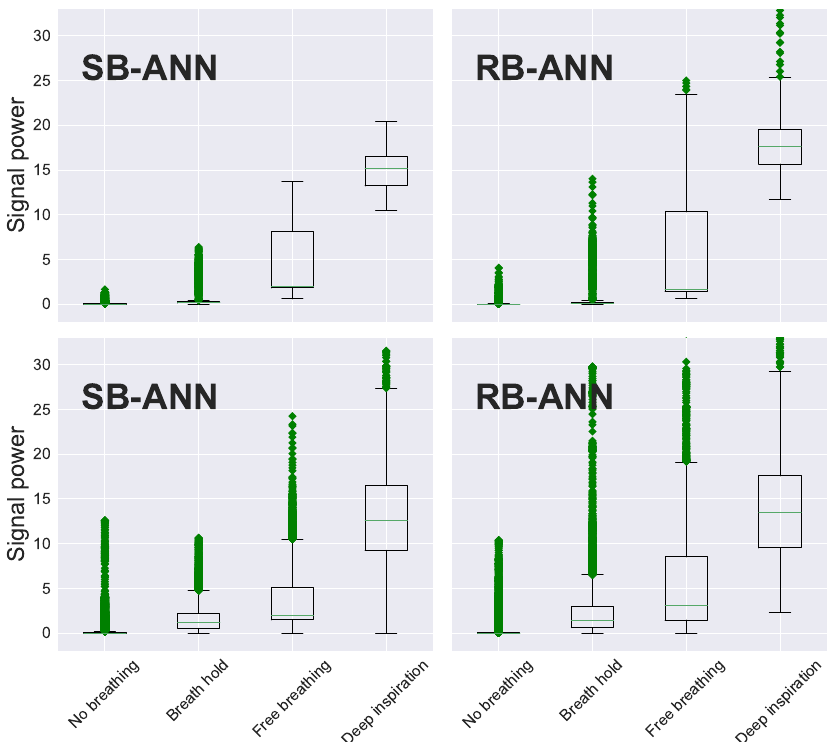
Figure 11. Box and whisker diagrams of radar-signal power for four categories of RMP-simulated breathing motion, with (gantry) and without (no-gantry) linac motion/operation, and after signal interference is removed: 1. No breathing (zero amplitude/signal power). 2. Breath hold (small amplitude/signal power), 3. Free (periodic) breathing, and 4. deep inspiration/exhalation (large amplitude/signal power). The boxes enclose the 2nd–3rd quartiles, while the whiskers outline the 2nd and 98th percentiles. The “+” symbols represent